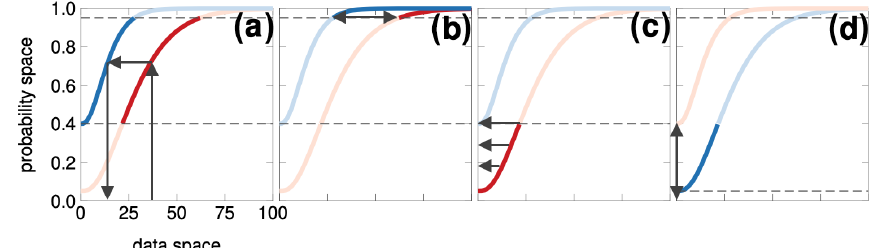
Figure A1. (a) Empirical quantile mapping between model-based (red) and reference (blue) data; (b) delta approach for correcting extreme values above the maximum Weibull quantiles; (c) correction of precipitation intermittency when the dry-day probability of the reference (lower dashed line) is higher; (d) correction of precipitation intermittency when the dry-day probability of the reference is